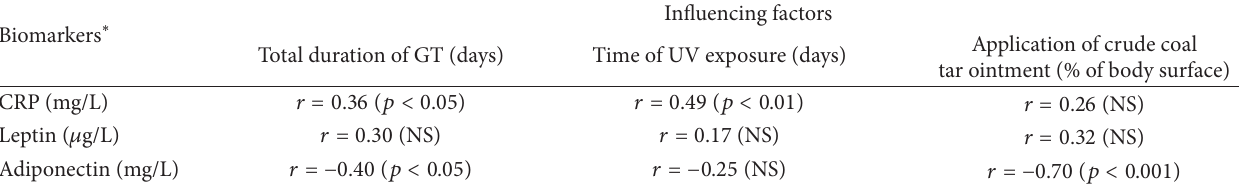
Table 1: Relationships among biomarkers and basic characteristics of the therapy.